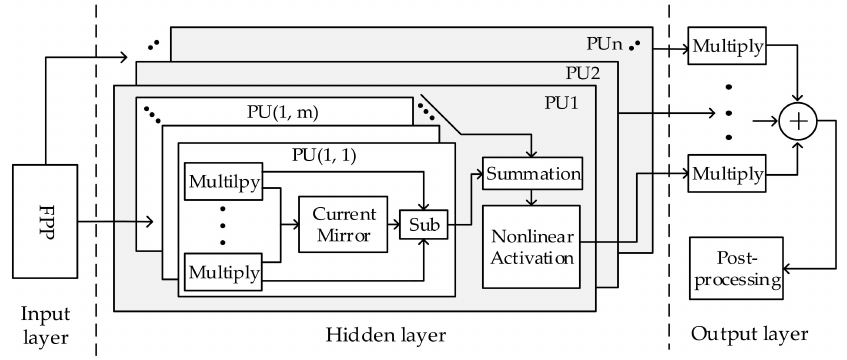
Figure 6. The computation process of multi-layer perception (MLP) based on flexible devices.